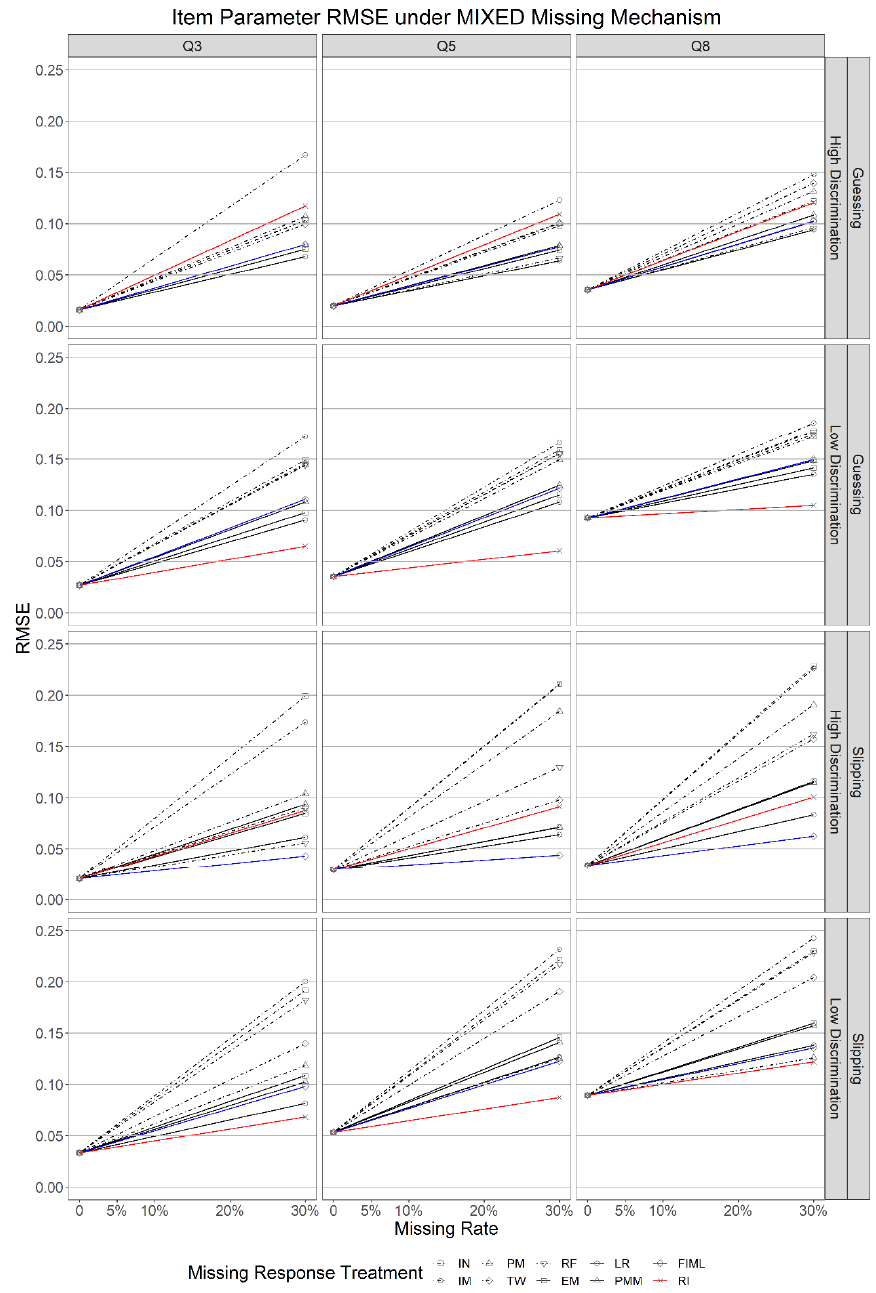
Figure 3. RMSE of item parameter estimations under the MIXED missing mechanism. Columns Q3, Q5, and Q8 present results for Q-matrices with three, five, and eight attributes, respectively, while rows refer to results across high and low discriminations for both guessing and slipping parameters.